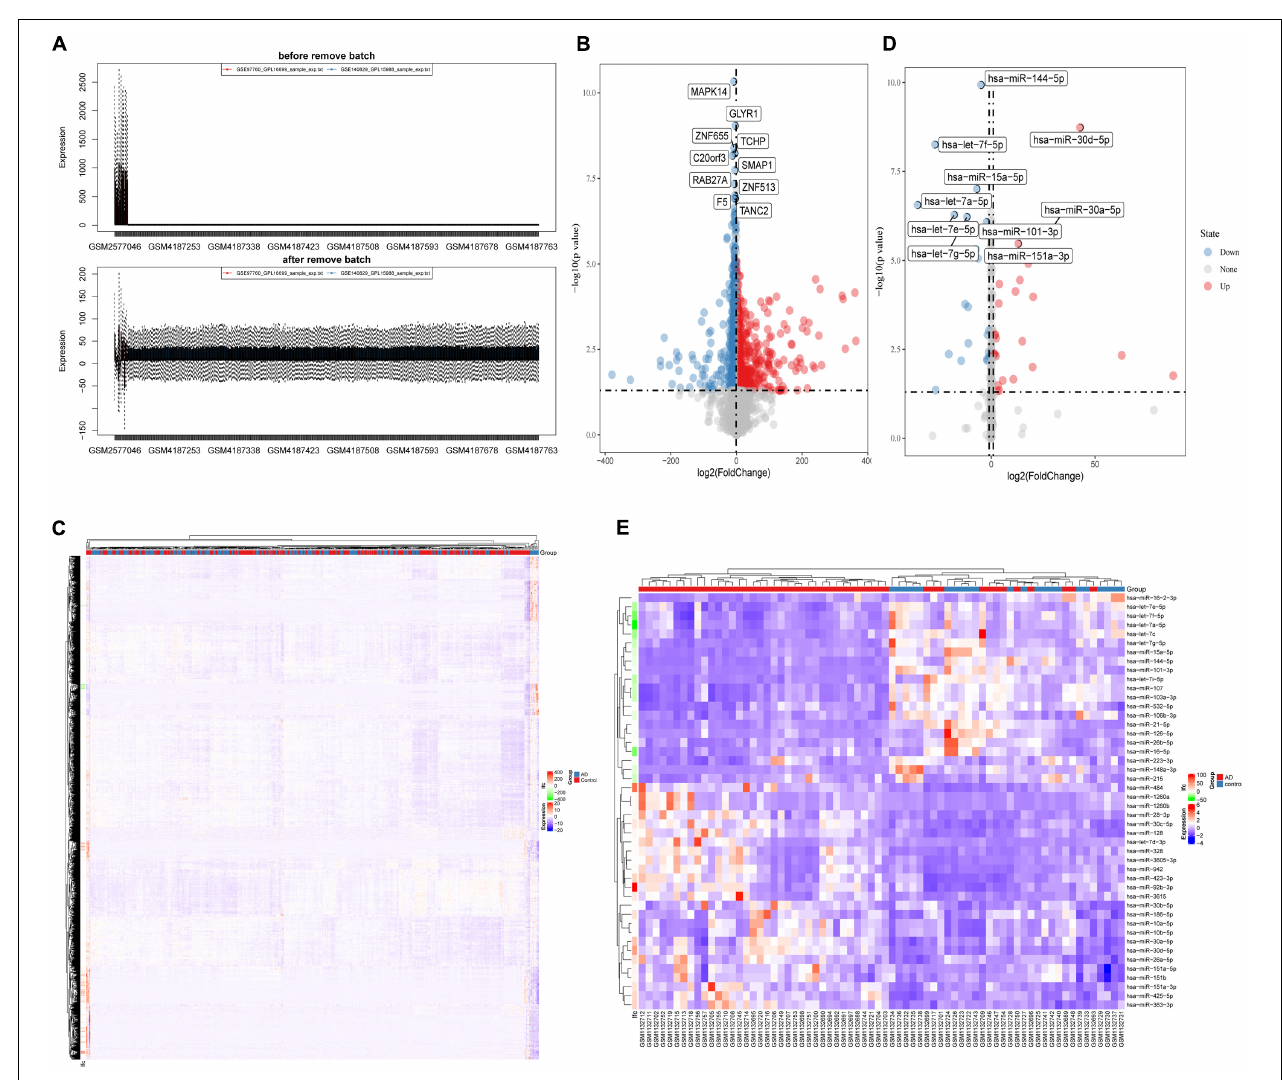
FIGURE 1 | (A) The SVA package removes the batch effect between GSE140829 and GSE97760. (B) Volcano plot and (C) heatmap for the differentially expressed mRNAs in the merged dataset (GSE140829 and GSE97760). (D) Volcano plot and (E) heatmap for the differentially expressed miRNAs in GSE46579. Red dots represent up regulation, blue dots represent down regulation, and gray dots represent non-differentially expressed RNA.